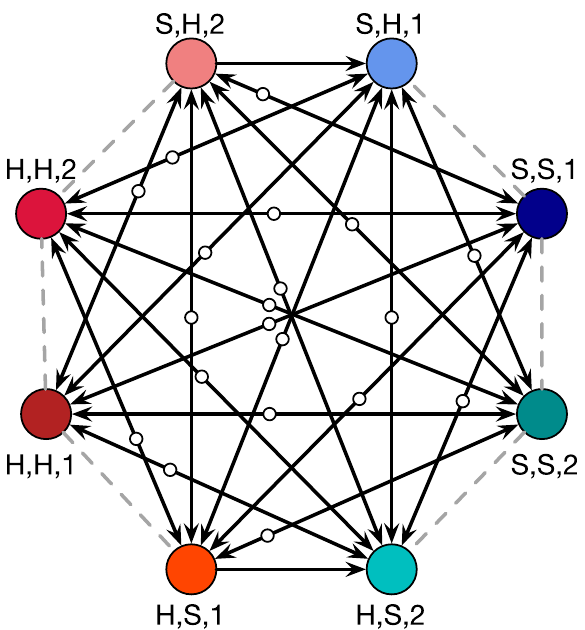
Fig. 2 Dynamics on the edges of the simplex. The dashed edges are neutrally stable whereas the directed edges show dominance. The edges with an open circle on them are all bi-stable (the circle marking the position of an unstable threshold as per Fig. SI.1), hence along those edges there would be no movement once the population is at a vertex. Once the population reaches the (H,S,2) or (S,H,1) state, it gets locked into the stag equilibrium and drifts between (H,S,2) – (S,S,2) – (S,S,1) – (S,H,1). Parameters are G = 5, M = 4, P S = 4 and P H = 1.